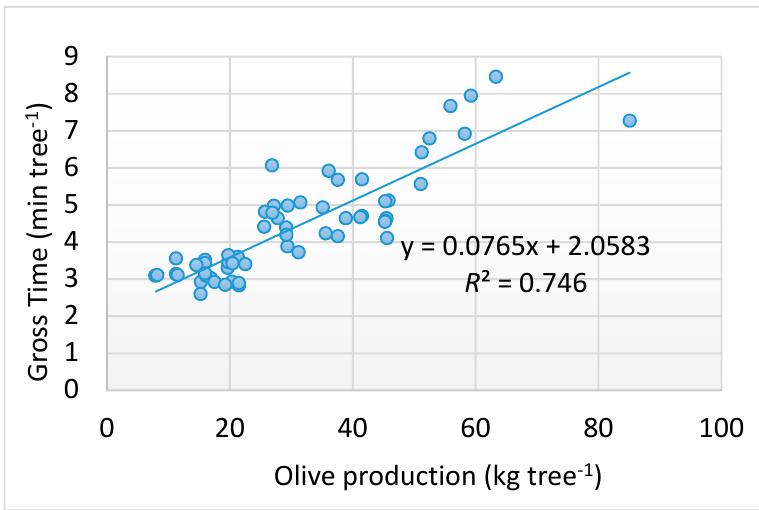
Figure 10. Relationship between gross time of the TTS application and olive production per tree.